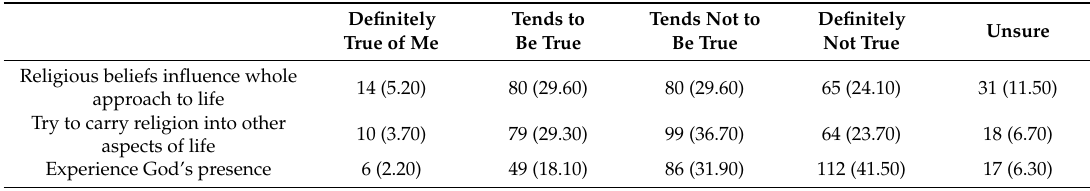
Table 2. Intrinsic religiosity of psychiatric sta ff 1